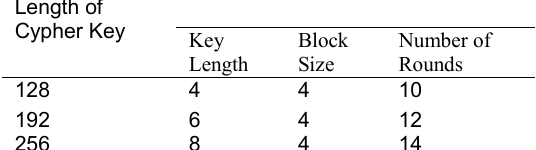
Table 1. Key Block Round Combination for AES